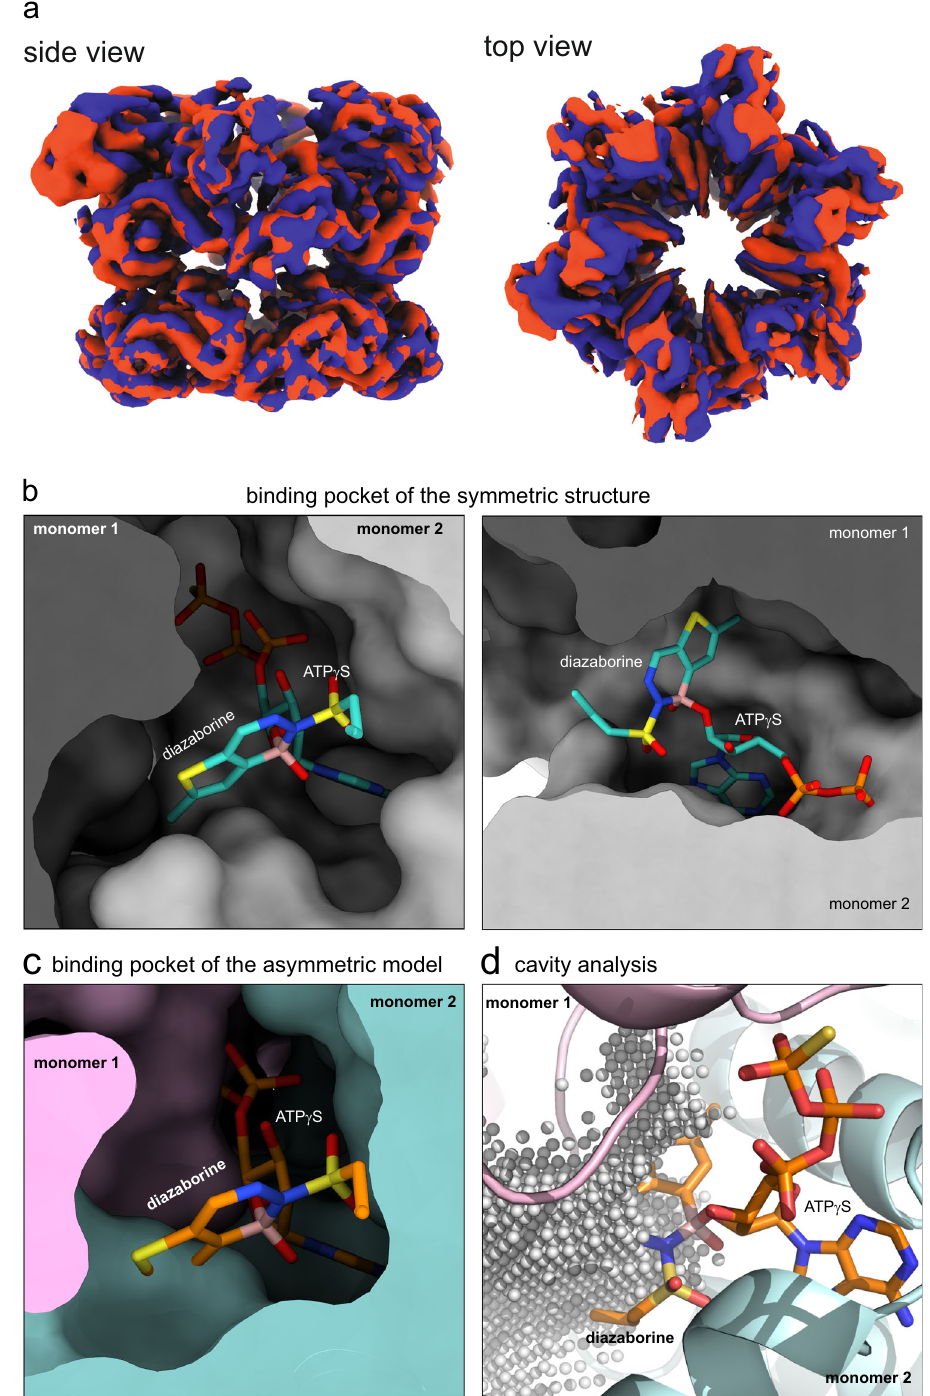
Fig. 3 Diazaborine prevents Drg1 to adopt an active state. a 3D variability analysis of the cryo-EM data revealed coordinated movements of the D1 and N- domains visualized by the superposition of two states (red and blue, see also Supplementary Movie 1). These movements visualize the conformational fl exibility of these domains needed to link ATP hydrolysis to mechanical substrate processing. The diazaborine loaded D2 domain is not participating in the coordinated movements. b Binding pocket of the experimentally determined symmetric structure in two orientations. c Diazaborine does not fi t into the binding pocket of the active-state model. Homology modeling of Drg1 D2 nucleotide-binding pockets in the asymmetric, active state based on a structure of Cdc48 (pdb-code 6OPC, ref. 27 ). The adduct was placed in the binding site by superimposing its ribose ring atoms on the corresponding moiety of the nucleotide (ADP) present in the homology model. The two protomers forming the nucleotide-binding site are shown in pink and light blue. In the binding pockets of this model, diazaborine severely clashes with α -helix 7. One site is exemplarily shown. d Cavity analysis of the binding pocket of the asymmetric model. The cavity in the vicinity of ADP is represented as light gray spheres. Larger parts of the diazaborine portion of the adduct not covered by the point cloud indicate that the inhibitor is incompatible with the available space in the active state of